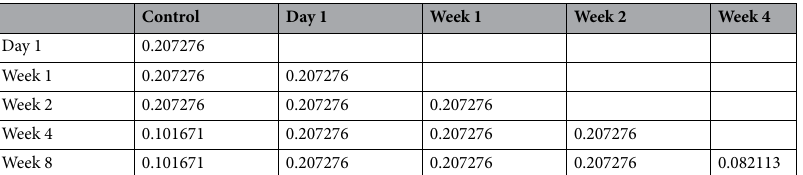
Table 4. The Jaccard’s dissimilarity distances between clonal Ananas comosus var. MD2 plantlets after gamma radiation treatment at different post-recovery periods (Day 1, Week 1, Week 2, Week 4 and Week 8), compared to